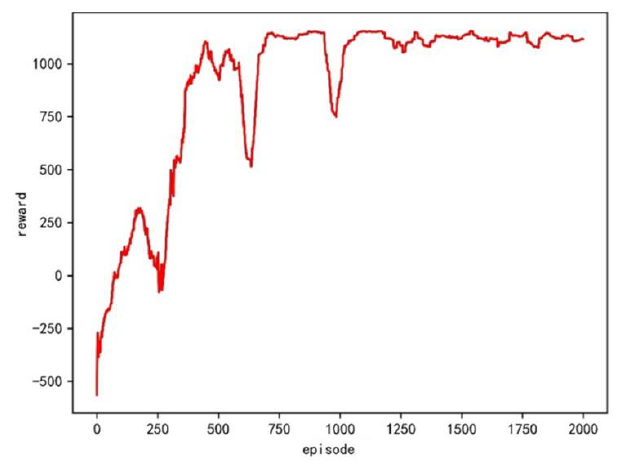
Figure 14. Reward when w = 0.7.